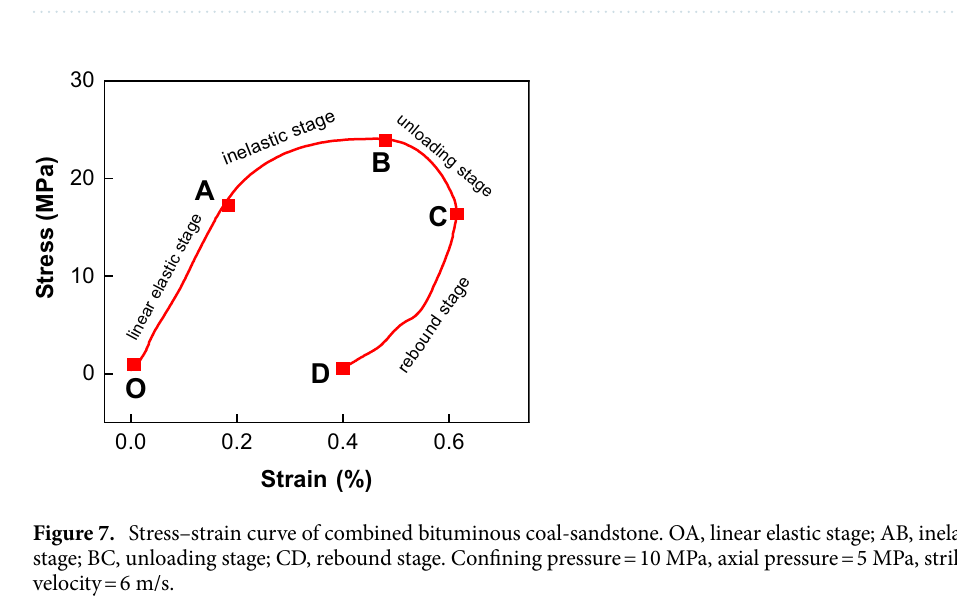
Figure 6. Stress–strain curves of sandstone, bituminous coal and combined bodies.